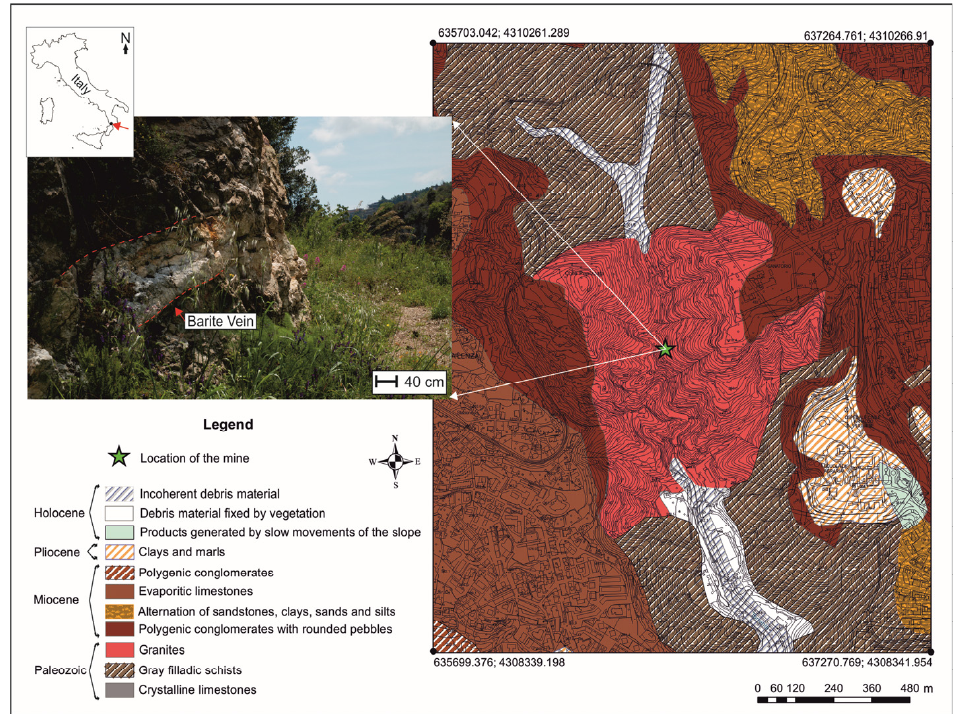
Figure 1. Location of the Mastricarro Barite Mine and geological map of the area (after [5,6]). The red arrow indicates the barite vein in which the anglesite, cerussite, gypsum, langite, malachite, and posnjakite crystals were found.